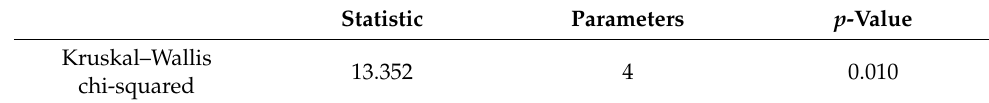
Table 8. Kruskal–Wallis test of the simulated portfolios’ ex-post Sharpe ratios.